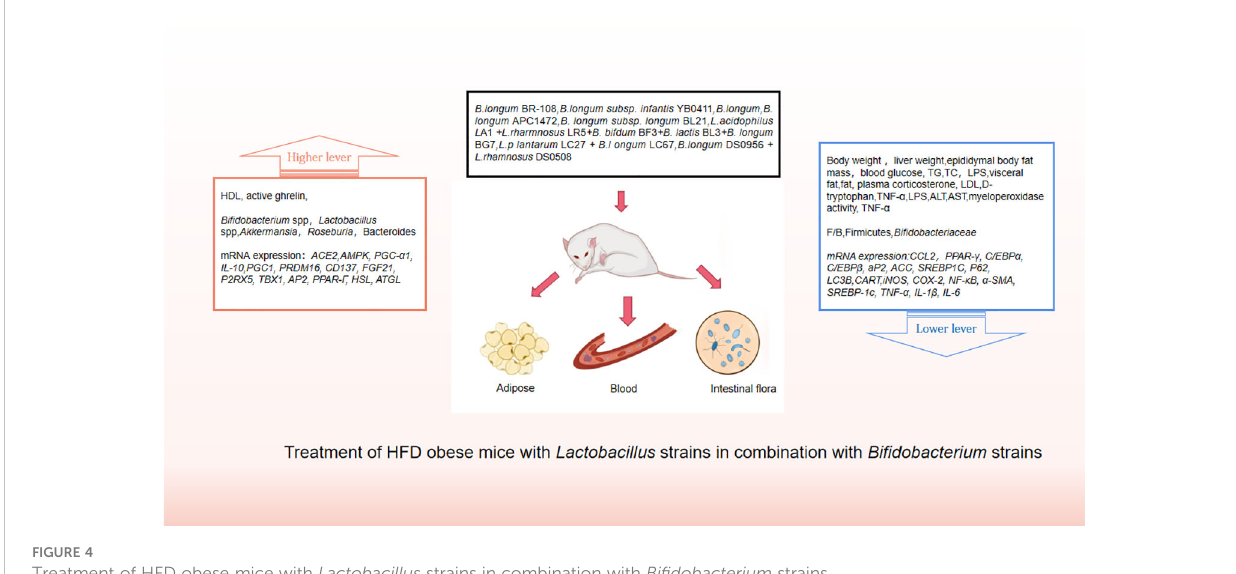
FIGURE 4 Treatment of HFD obese mice with Lactobacillus strains in combination with Bi fi dobacterium